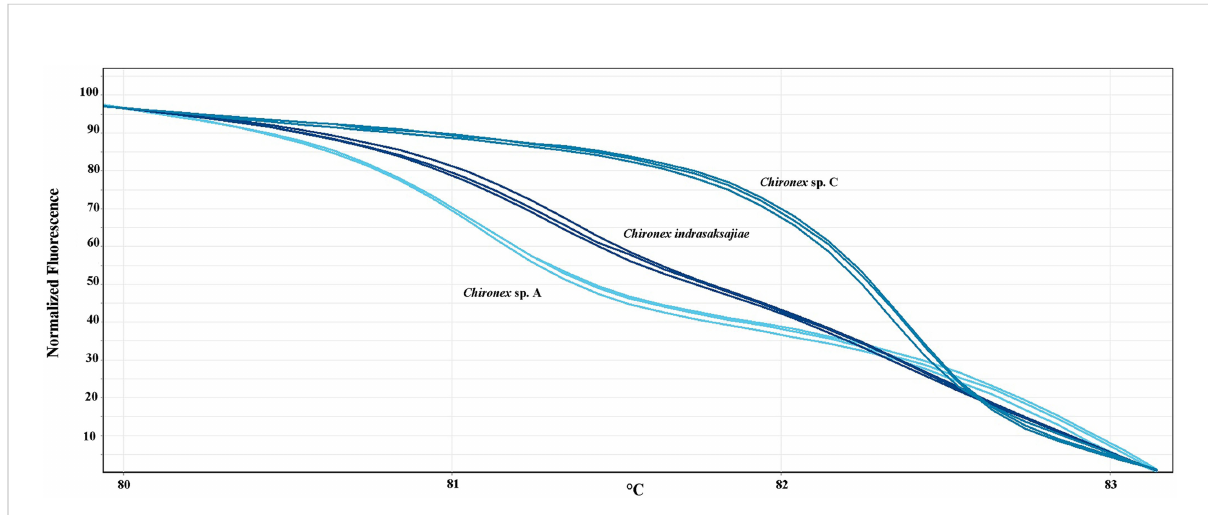
FIGURE 3 Normalized melting curves of three chironex species showing at temperatures 80-83°C.